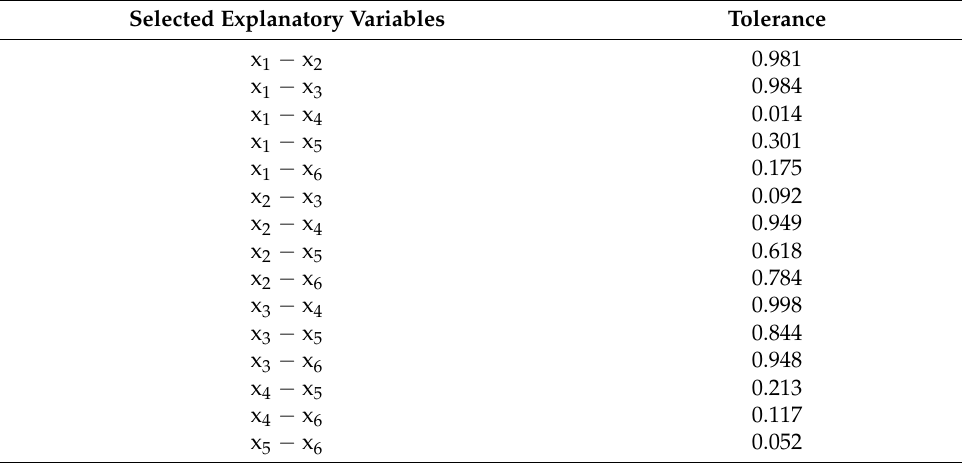
Table 5. Tolerance between selected explanatory variables.